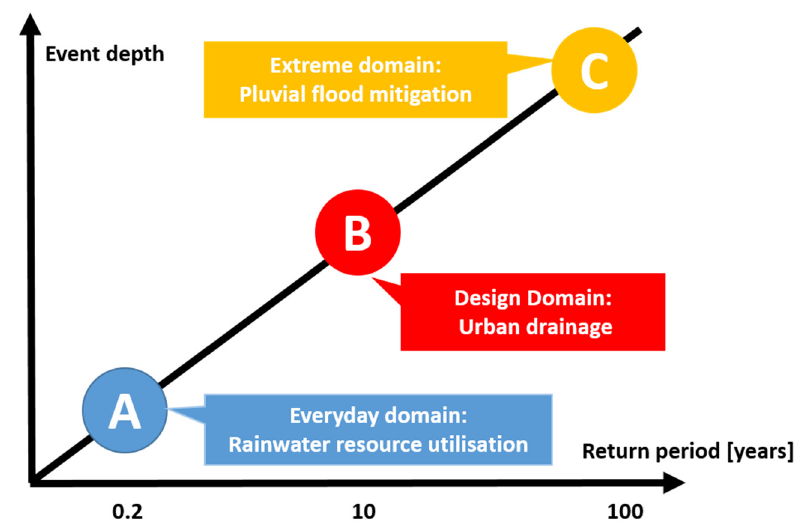
Figure 1. The Three Point Approach. Figure adapted from [8].